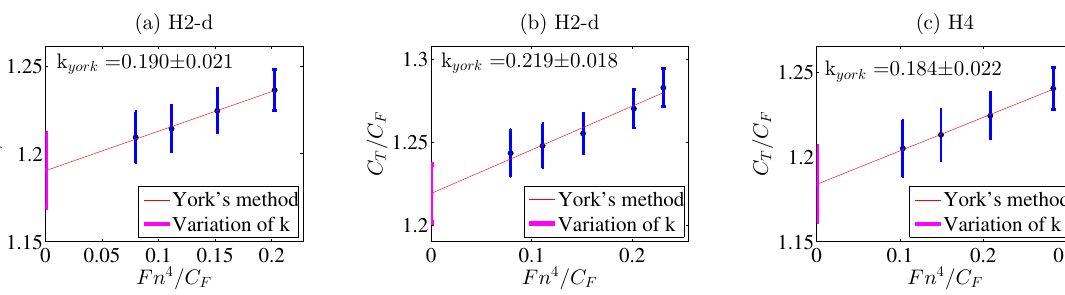
Figure 13. Prohaska plot of test cases in design and scantling loading conditions: ( a ) H2-d, ( b ) H2-d, ( c ) H4.